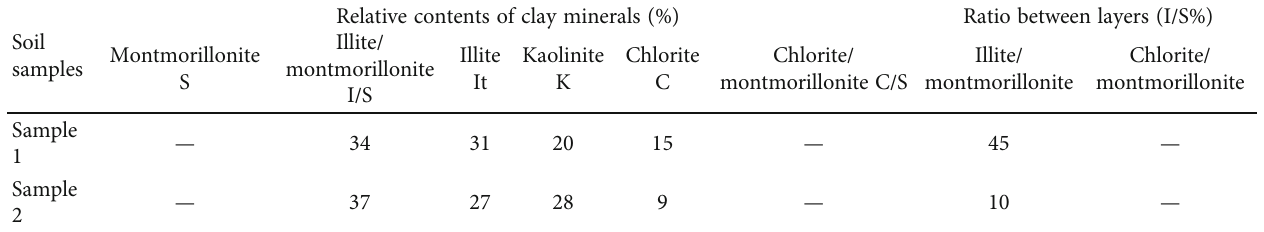
Table 2: Relative contents of clay minerals in the representative soil samples.